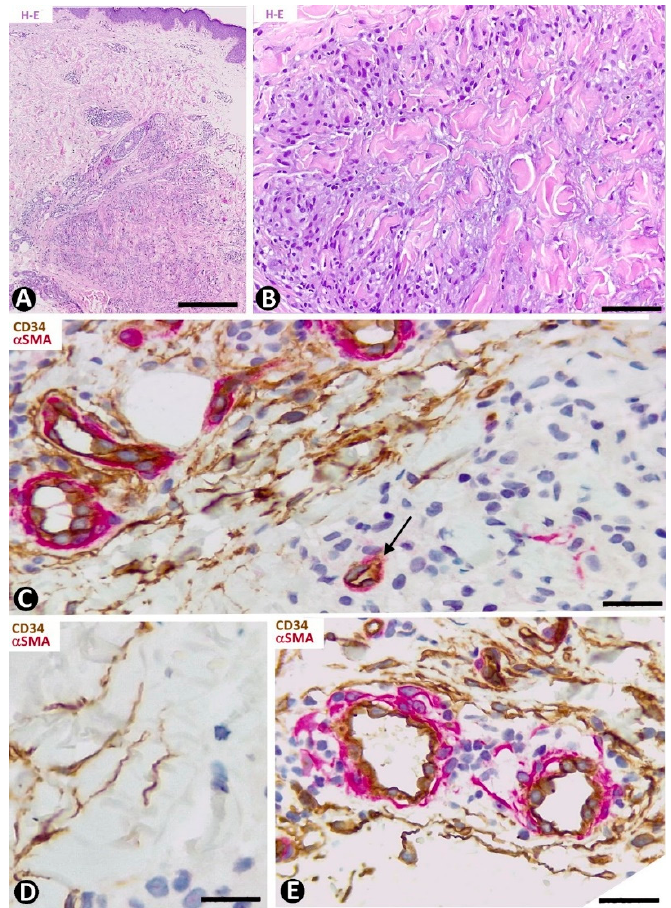
Figure 10. CD34+SCs/TCs in the granuloma annulare. ( A , B ) Hematoxylin–eosin staining. ( C – E ) Double immunochemistry for CD34 (brown) and α SMA (red). Hematoxylin counterstain. ( A , B ) Images at different magnifications, showing dermal location, palisading inflammatory infiltrate and mucin deposition. ( C , D ) Perivascular and interstitial CD34+SCs/TCs (brown) around the granuloma. Note in C the absence of CD34+SCs/TCs around a vessel within the granuloma (arrow). ( E ) Small accumulation of lymphocytes between perivascular CD34+SCs/TCs (brown) and vessel mural cells (red). Bar: ( A ) 150 µm, ( B ) 80 µm, ( C , E ) 55 µm, ( D ) 45 µm.